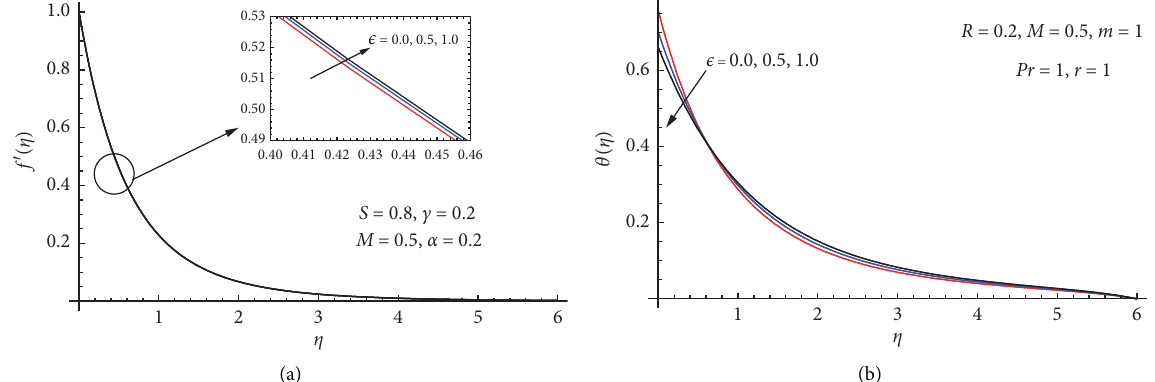
Figure 7: (a) Velocity distribution for ϵ . (b) Temperature distribution for ϵ .